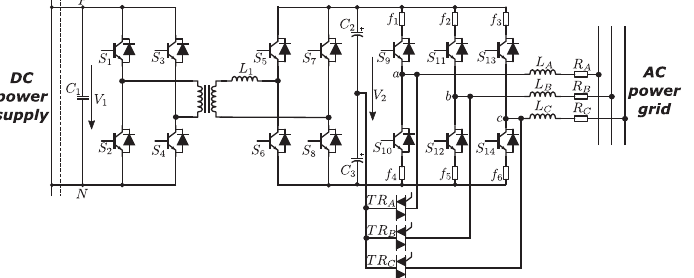
Figure 7. Topology of bidirectional AC/DC converter. On the AC side, three TRIACS are connected as bidirectional switches between the phases and the center point of the split capacitance; when a fault occurs in the phase leg, the fuse f 1 , f 2 or f 3 is disconnected, and the respective TRIAC ( TR A , TR B , or TR C ) is triggered.